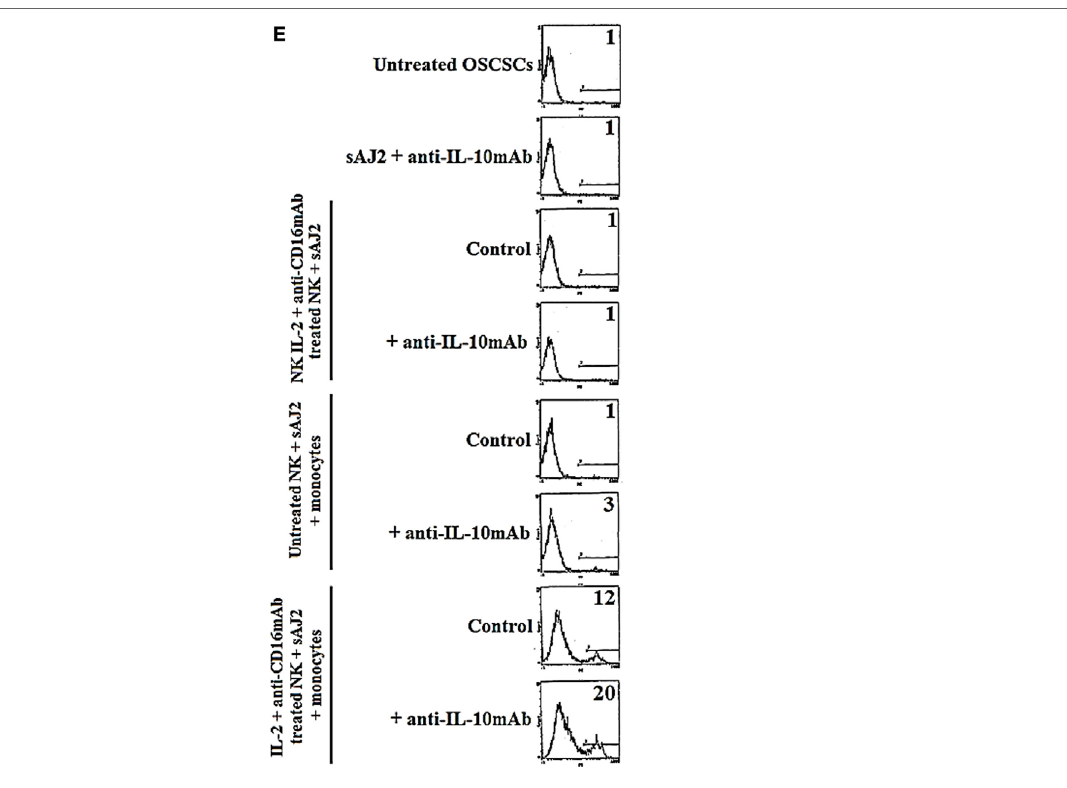
FigUre 5 | continued After an overnight treatment period, the supernatants were removed and added to OSCSCs for 3 days (c) . NK cells supernatants were prepared as described in (a) and added to OSCSCs for 3 days (D) . Afterwards, untreated and treated OSCSCs were detached from the tissue culture plate and washed with 1× PBS. The surface expression of B7H1, CD54, MHC-1, and CD44 was assessed after staining with the PE-conjugated antibodies and analyzed using flow cytometry. Isotype control antibodies were used as controls. The numbers on the right-hand corner are the percentages, and the mean channel fluorescence intensities for each histogram (c) and (D) . OSCSCs were differentiated with NK cell supernatants as described in (D) , and at the end of the treatment period, the viability of OSCSCs was assessed with propidium iodide staining followed by flow cytometric analysis (e) . The numbers on the right hand corner are the percentages of dead cells in each